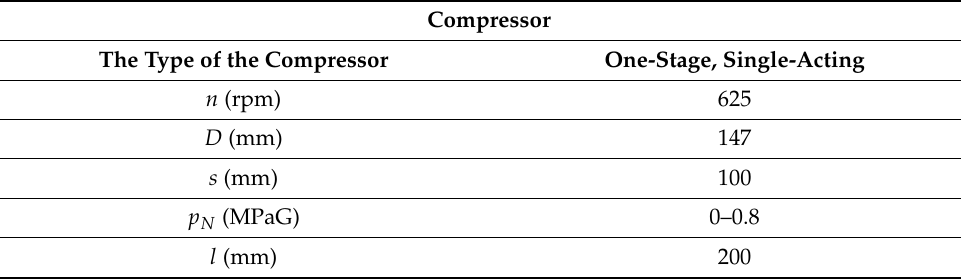
Figure 5. Schematic of reciprocating compressor test rig. Table 2. Parameters of the studied